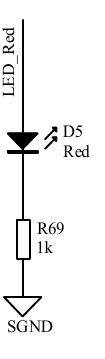
Figure 2. 2.5 V reference source circuit.